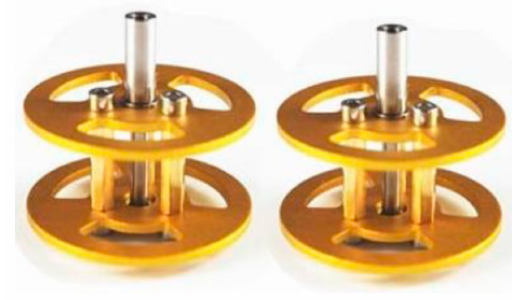
Figure 7. Bearing wheels.